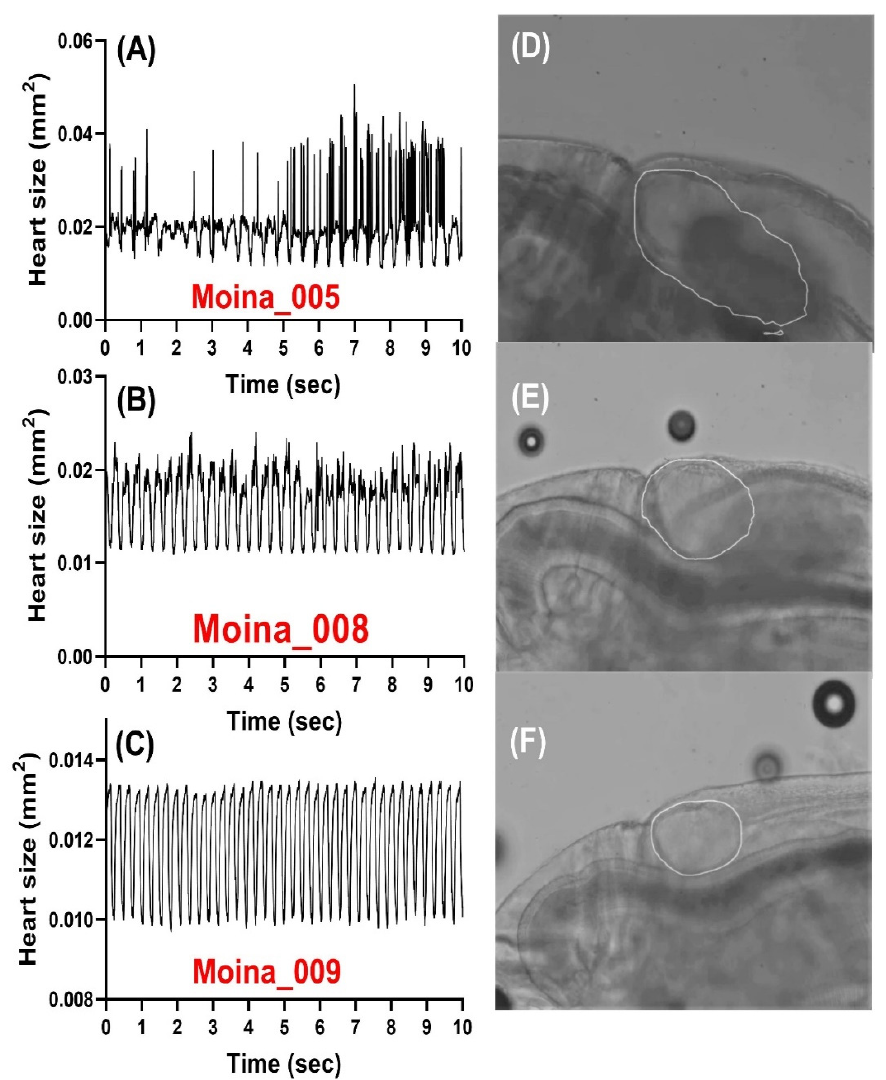
Figure A3. Image of Moina sp. cardiac chamber and peak profile of the predicted heart area size over time. The heart chamber detection accuracy was lower if the brood was presented in the brood Figure A3. The image of Moina sp. shows the limitation of the tool. The heart chamber detection chamber ( D , E ) shown by irregular peak pattern ( A , B ) when compared to the one without brood in accuracy was lower if the brood was presented in the brood chamber ( A , B ) compared to the one without brood in the chamber ( C ), ( D , E , F ) brood chamber. the chamber ( C , F